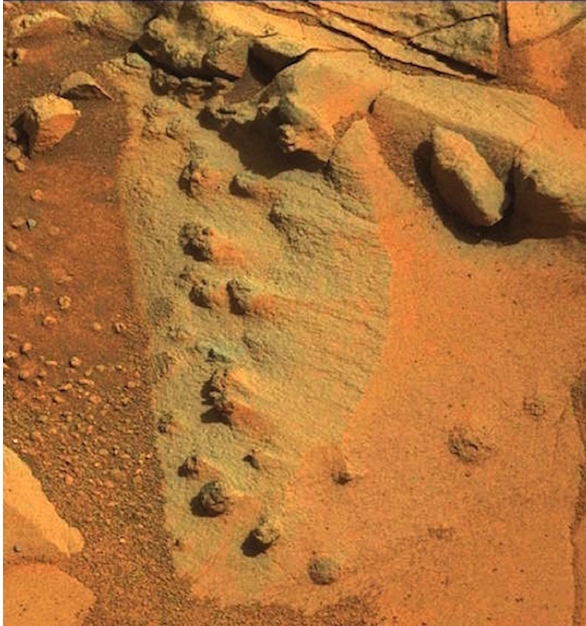
Figure 8. Mars. Sol 871. Green sphericals upon Martian sand, soil, rocks and pinnicle-columnar structures resembling terrestrial stromatolites and thrombolites and algae growing in shallow water, but may be frozen. On Earth, the greenish-coloration of sand and rock is due to green cryptoendolithic cyanobacteria. The darkening in soil coloration may indicate moisture. Photographed in Gale Crater. (Reproduced with permission from Joseph et al. 2020a).